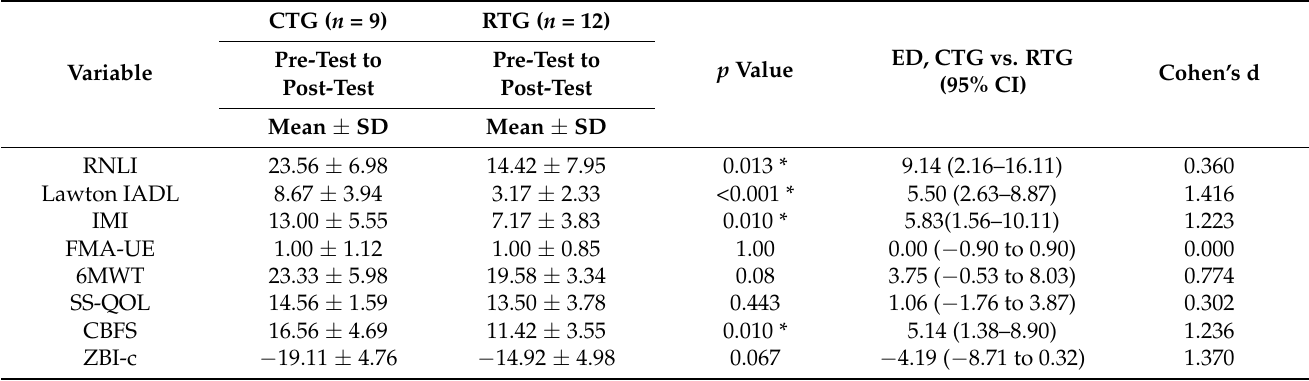
Table 3. Mean changes from pre-test to post-test for effectiveness outcome measures between the intervention and control